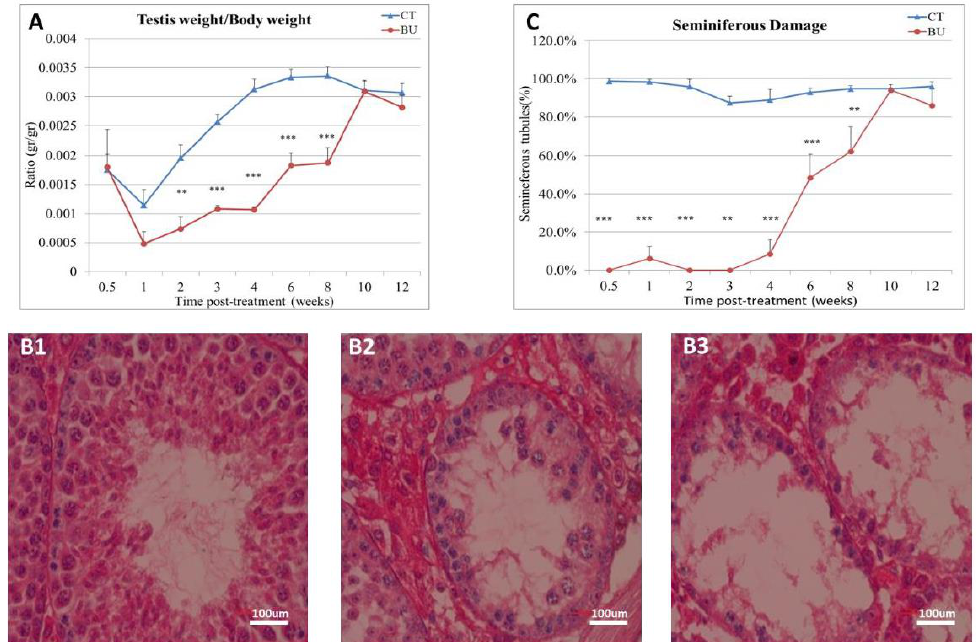
Figure 1. Effect of busulfan (BU) on testicular and body weight and on testicular histology: BU was intraperitoneally injected (i.p; 45 mg/kg in 100 µL). After 0.5–12 weeks, mice were weighed, and the testes were removed and weighed. Part of the testes were fixed in Bouin’s solution (for histological evaluation), while the other part was frozen at −70 °C for RNA extraction and/or for the preparation of total protein. The ratio of the testes weight/body weight after 0.5–12 weeks of BU injection compared to the control (CT) (DMSO) is presented ( A ). The histology of the seminiferous tubules after BU treatment was normal ( B1 ), showed moderate damage ( B2 ), or showed severe damage ( B3 ). A summary of the seminiferous tubule damage after 0.5–12 weeks of BU treatment compared to the CT is presented ( C ). ×40 light microscope magnification (100 µm scale). ** p < 0.01 and *** p < 0.001